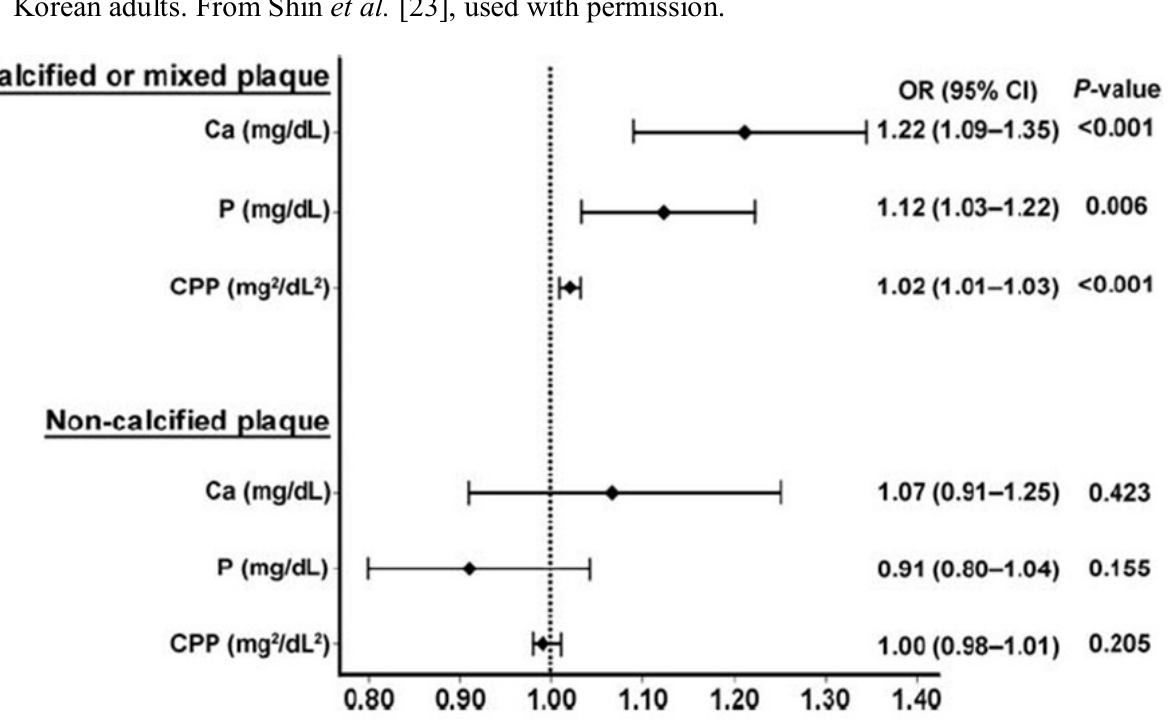
Figure 2. The association of serum calcium, phosphate, and calcium–phosphate product with the presence of coronary artery disease, divided into calcified or mixed plaque, and non-calcified plaque. Plaque was measured by cardiac computed tomography in 7553 Korean adults. From Shin et al. [23], used with